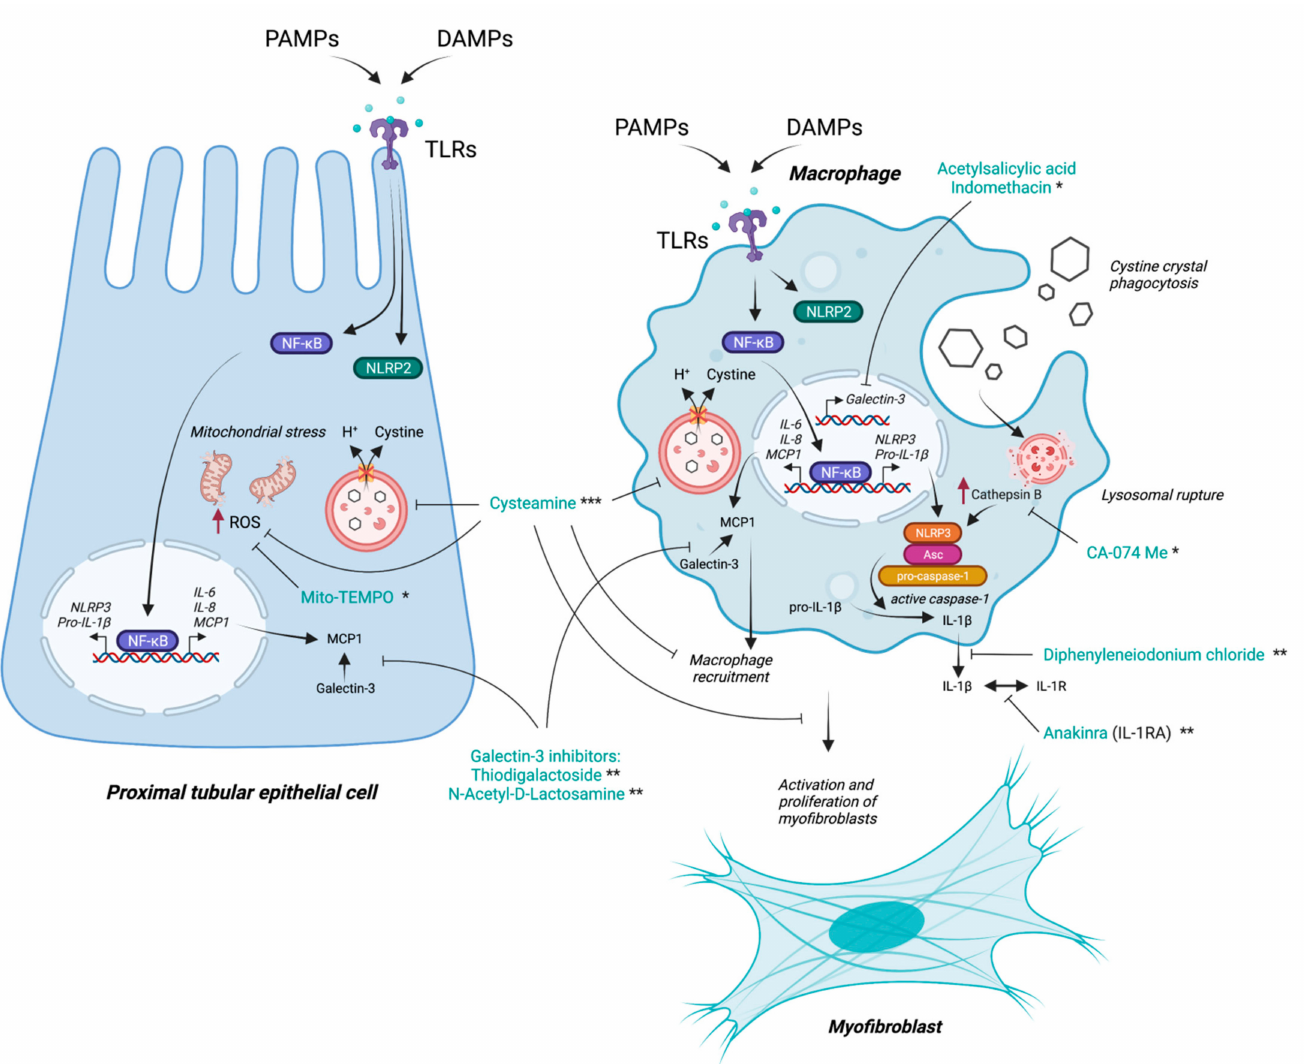
Figure 4. Inflammatory pathways in key cells involved in the pathophysiology of cystinosis and mechanisms of action of current and potential future therapeutic agents. Proximal tubular epithe- lial cells (PTECs), macrophages, and myofibroblasts are key cell players in the proximal tubular dysfunction and progressive chronic kidney disease, which characterizes cystinosis. Therapeutic agents are depicted with their specific mechanisms of action and classified according to the current evidence. * In vitro cellular models, **: in vivo animal models, ***: in vivo clinical-grade patient data. DAMPs, Damage-associated molecular patterns; IL, interleukin; MCP-1, monocytechemoattractant protein-1; NF- κ B, nuclear factor kappa light chain enhancerof activated B cells; NLRP2, NLR family pyrin domain containing 2; PAMPs, pathogen-associated molecular patterns; ROS, reactive